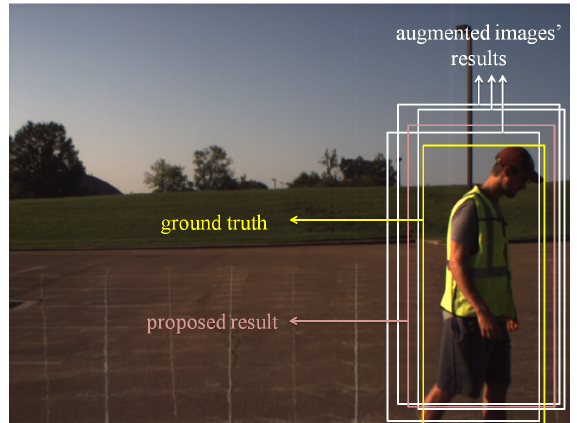
Figure 11. Fusion of three detection AABBs (white) into one AABB (pink), compared with the ground-truth (yellow).